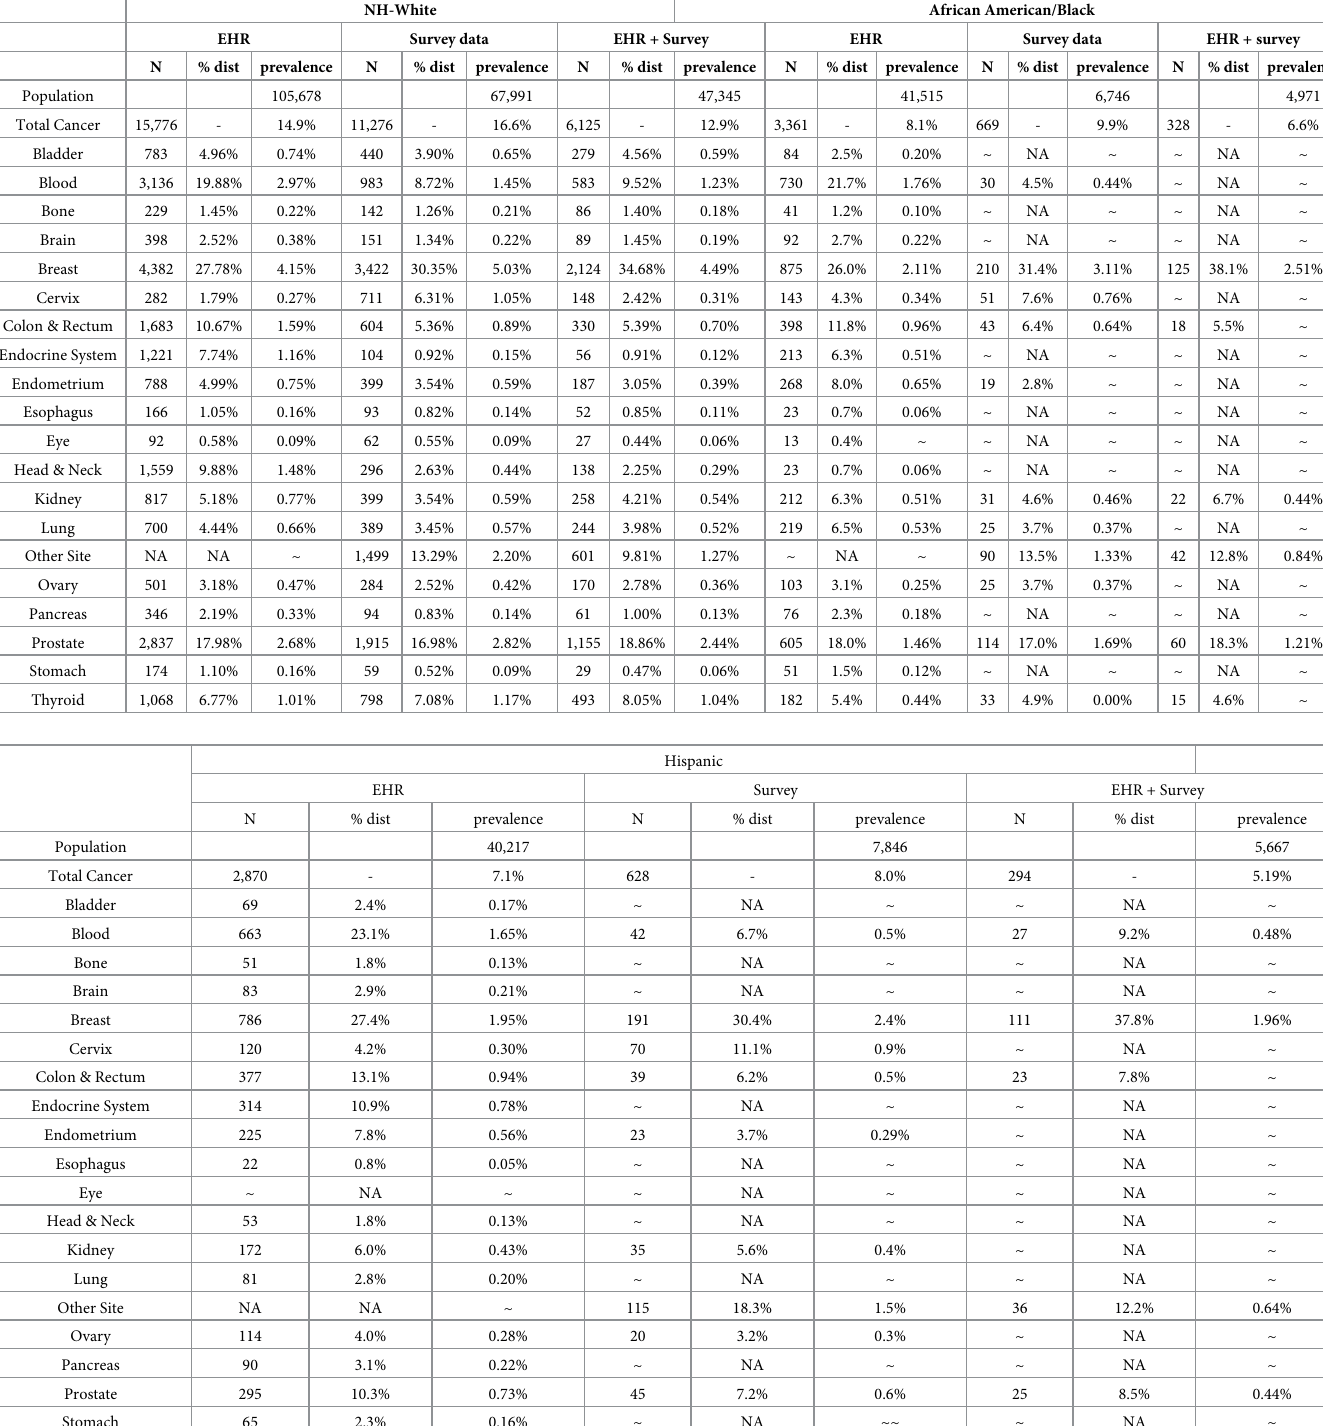
Table 3. The relative distribution and prevalence of cancer cases by type in the All of Us Research Program from self-reported survey data and electronic medical record by race/ethnicity. NH-White AfricanAmerican/Black EHR Surveydata EHR+Survey EHR Surveydata EHR+survey N % dist prevalence Population TotalCancer Bladder Bone 229 Brain 398 2.52% Breast 4,382 27.78% Cervix 282 ~ Colon &Rectum 1,683 10.67% EndocrineSystem